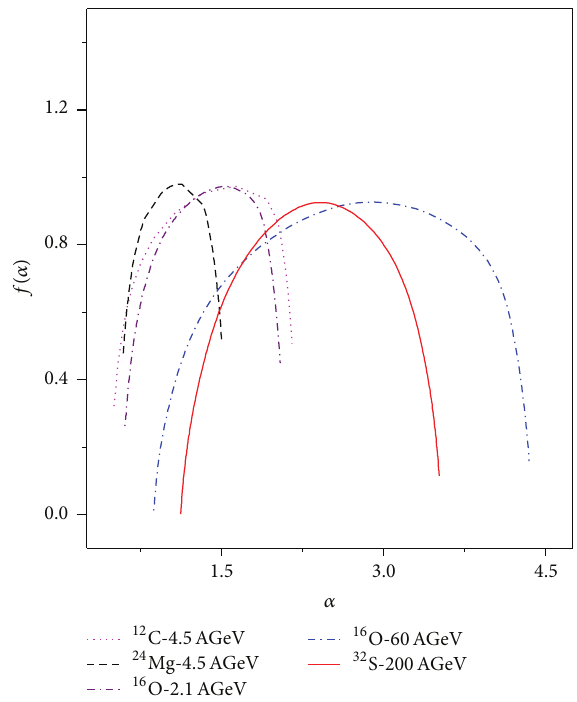
Figure 6: Multifractal spectrum for the considered interactions.